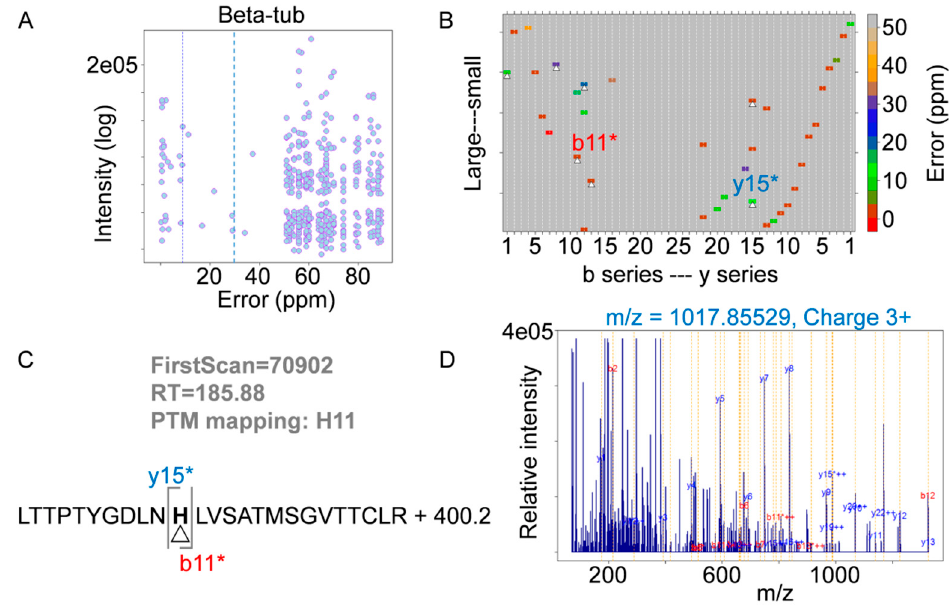
Figure 3. Mass spectrometry analyses of the cyclostreptin-tubulin adduct. ( A ) Vseq results of the cyclostreptin adduct of the beta tubulin-derived tryptic peptide spanning the sequence LTTPTYGDLNHLVSATMSGVTTCLR. Low error fragments (less than 30 ppm) were intense signals in the corresponding fragmentation spectrum and belong to one of the main fragmentation series derived by HCD (b and y series) as can be observed in ( B ). ( C ) Pinpointing of the exact position of the cyclostreptin modification. Vseq determined the Dmass corresponding to cyclostreptin (400.2 Da) and it mapped the modification in the H11 residue, since b11 and y15 fragments were unambiguously detected with the Dmass (labeled as a white triangle in ( B ) and with an * in ( C )). The corresponding fragmentation spectrum showing the different fragments assigned is displayed in ( D ).